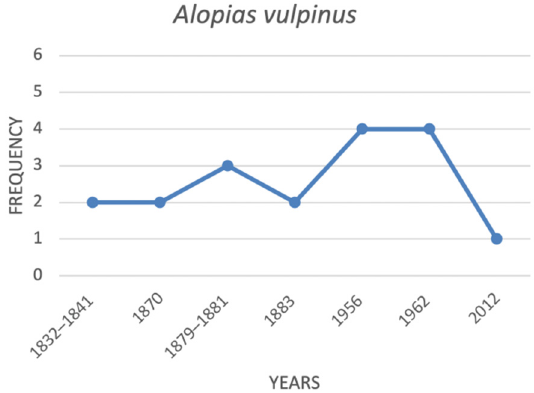
Figure 6. Temporal trend of Alopias vulpinus .